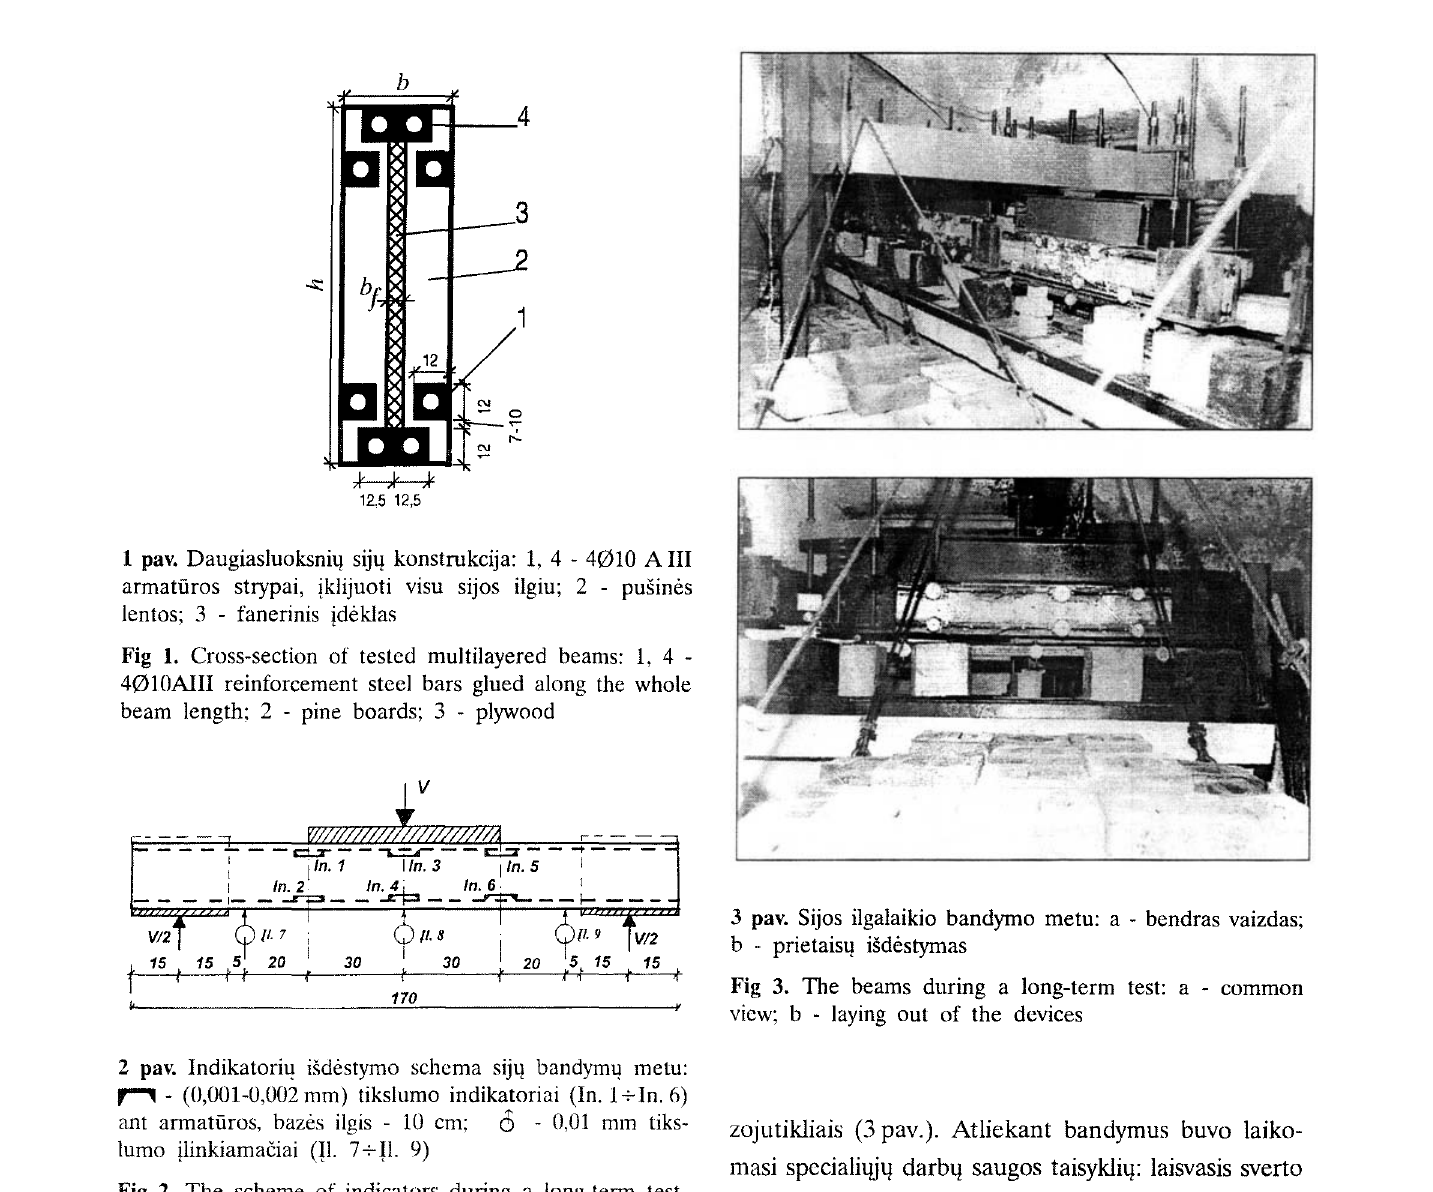
Fig 3. The beams during a long-term test: a - common view; b - laying out of the